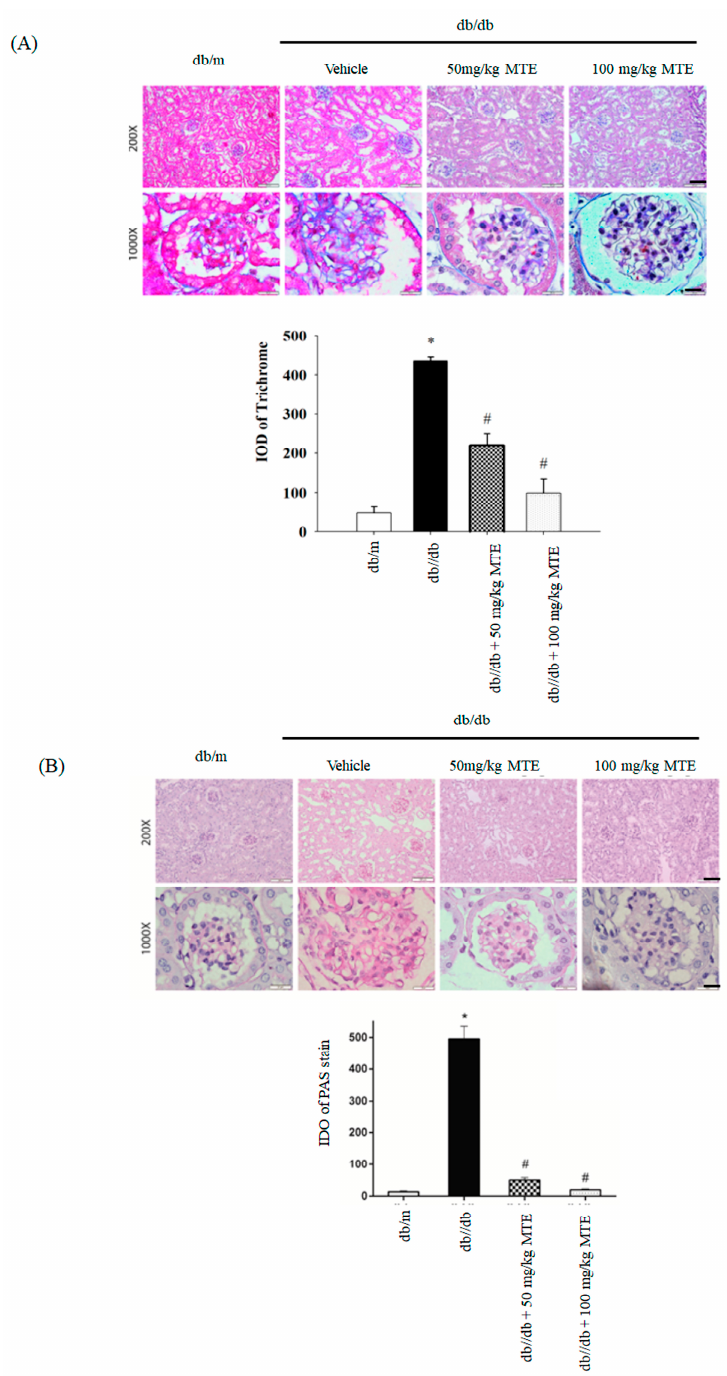
Figure 5. MTE reduced renal fibrosis in the diabetic mice. Trichrome ( A ) and PAS ( B ) staining of glomerulus derived from dd/db mice given 0, 50, or 100 mg/kg MTE. The db/m group was used as a negative control. (B) The lower panel represents the means and standard deviation of IDO obtained from six mice. *: p < 0.005 compared with the db/m mice. #: p < 0.005 compared with the db/db mice without MTE. Scale bar: 100 μ m at 100× and 20 μ m at 1000×.